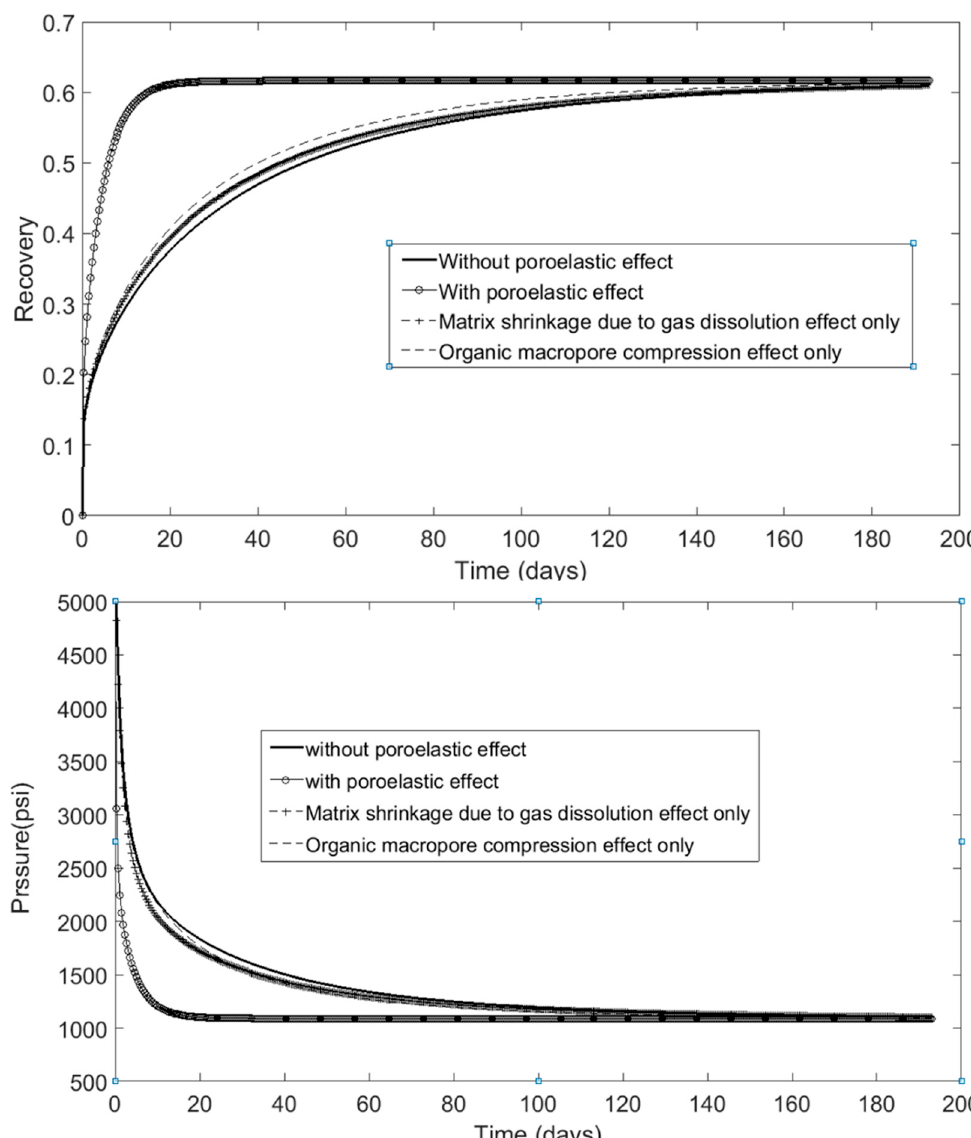
Figure 6. Comparisons of the effects of a 1 (organic macropore compression), a 2 (shrinkage and swelling) and a 3 (desorption-induced matrix deformation) on pressure decay ( bottom ) and ultimate recovery ( top ).